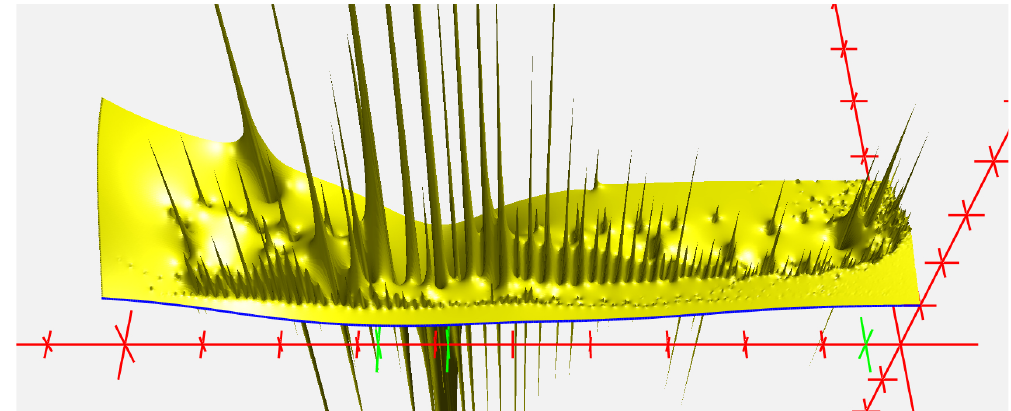
Fig. 7. Close-up near the origin (region (0, 0) to (5, − 2)) of the real component of the response function at Portishead. Axes as in Fig.